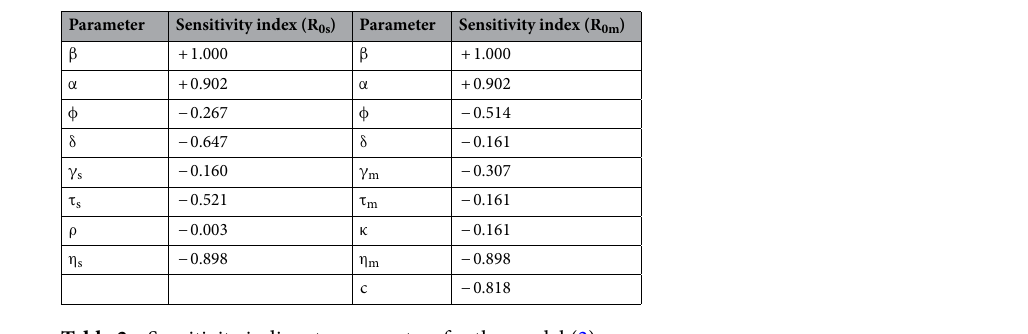
Table 2. Sensitivity indices to parameters for the model